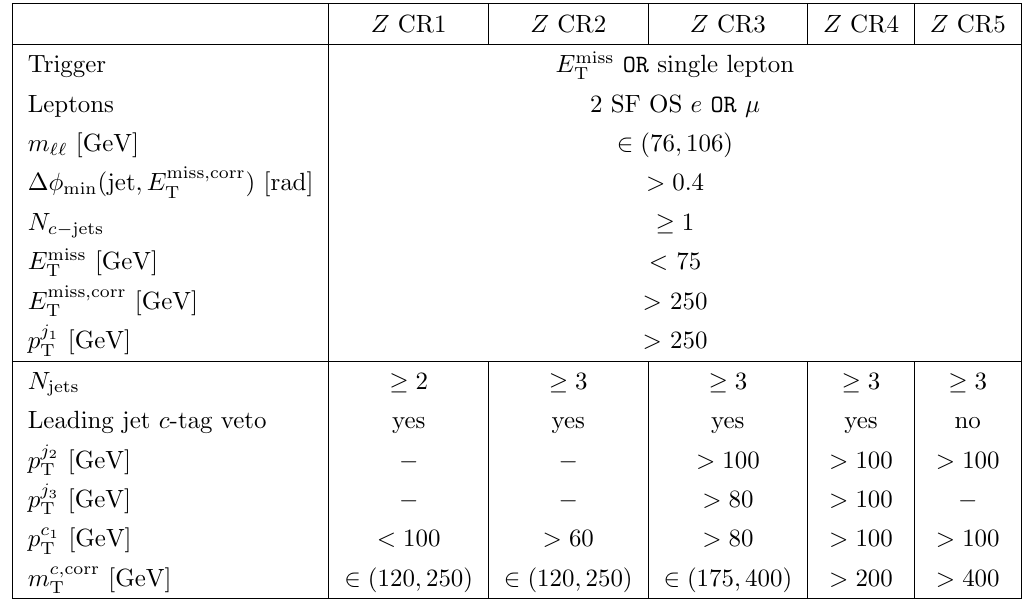
Table 2 . Overview of the Z control region selection criteria. N jets and N c (cid:0) jets indicate the total number of jets and c -jets, respectively; p j 1 leading, sub-leading and sub-sub-leading jet; and p c 1 the highest p T . Variables with the superscript \corr" refer to variables corrected as described in the